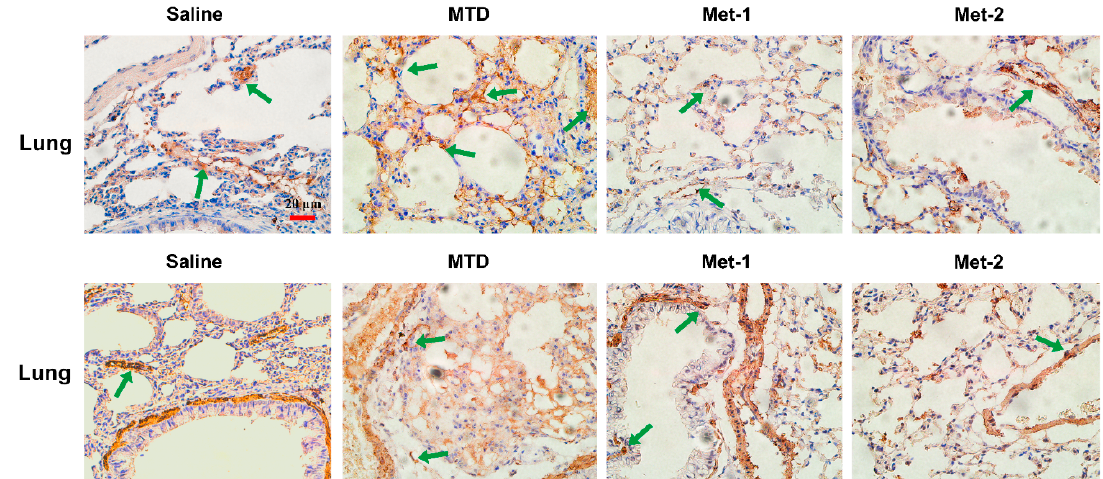
Figure 10. Immunohistochemistry of FSP-1 and α -SMA in the lung. Immunohistochemistry of the lung for FSP-1 marker (showed by green arrow) of fibroblasts and α -SMA marker of myofibroblasts was performed as previously described. Scale bar = 20 μ m.